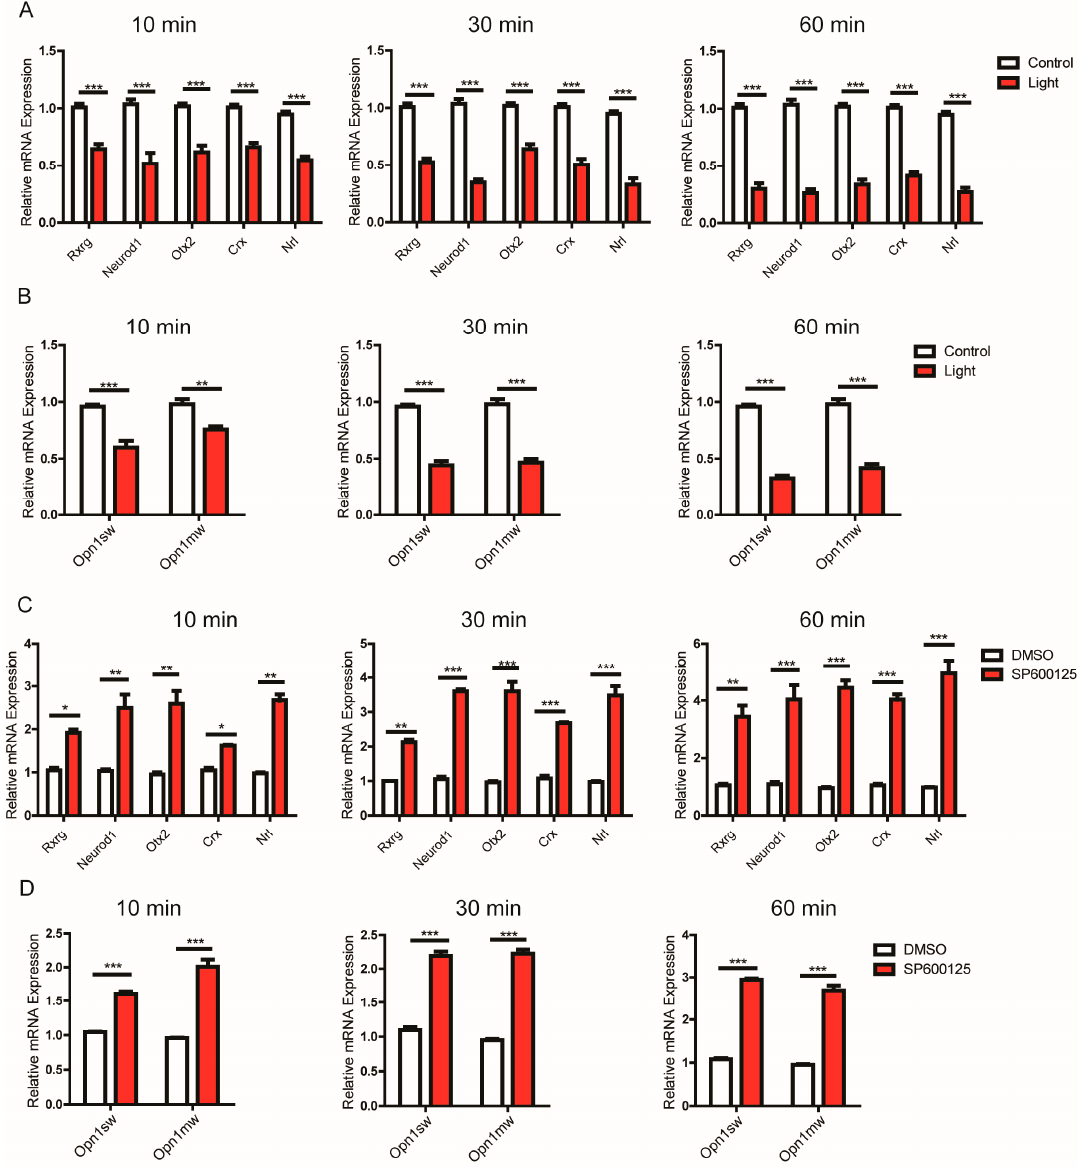
Figure 5. JNK1 attenuated the expression of photoreceptor-related genes in 661w cells: ( A , B ) 661W cells were treated by light for the indicated times, and 661W cells were treated with no light as a control. The alternation of Rxrg , Neurod1 , Otx2 , Crx, Nrl , Opn1sw , and Opn1mw mRNAs was then measured by quantitative PCR. ( C , D ) Here, 661W cells were treated with DMSO and 20 μ mol/mL SP600125 for 2 h and were then treated by light for the indicated times. The alternation of Rxrg , Neurod1 , Otx2 , Crx, Nrl , Opn1sw , and Opn1mw mRNAs was measured by quantitative PCR. Graphs show the mean ± SEM, and the data (A–D) shown are representative of three independent experiments. * p < 0.05, ** p < 0.01, *** p < 0.001 (Wilcoxon–Mann–Whitney test).